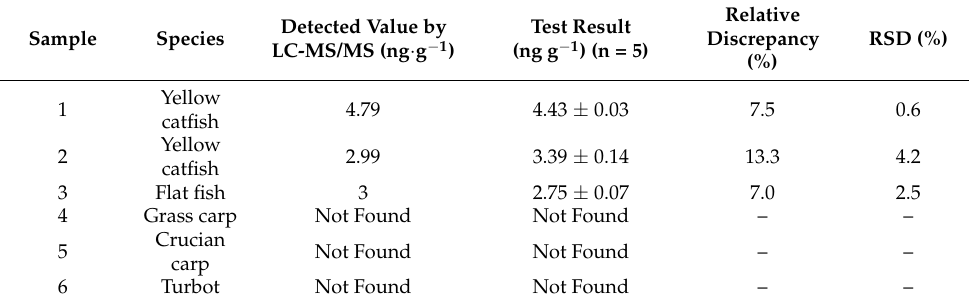
Table 3. Test results for real samples.